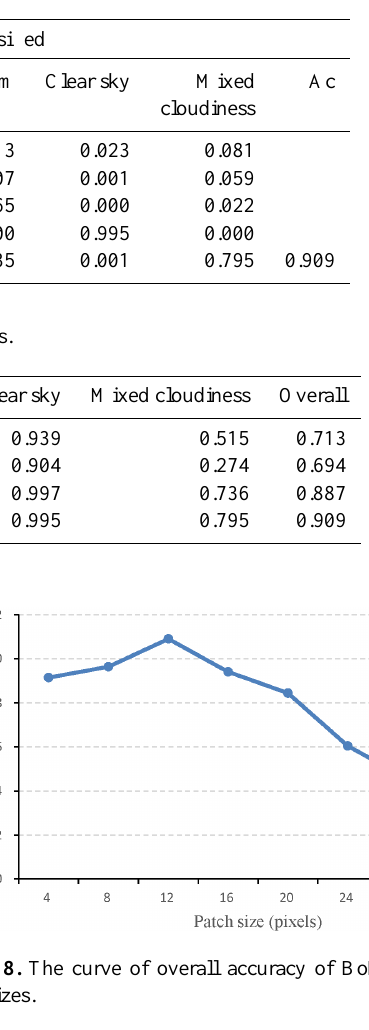
Table 2. Confusion matrix of BoMS.